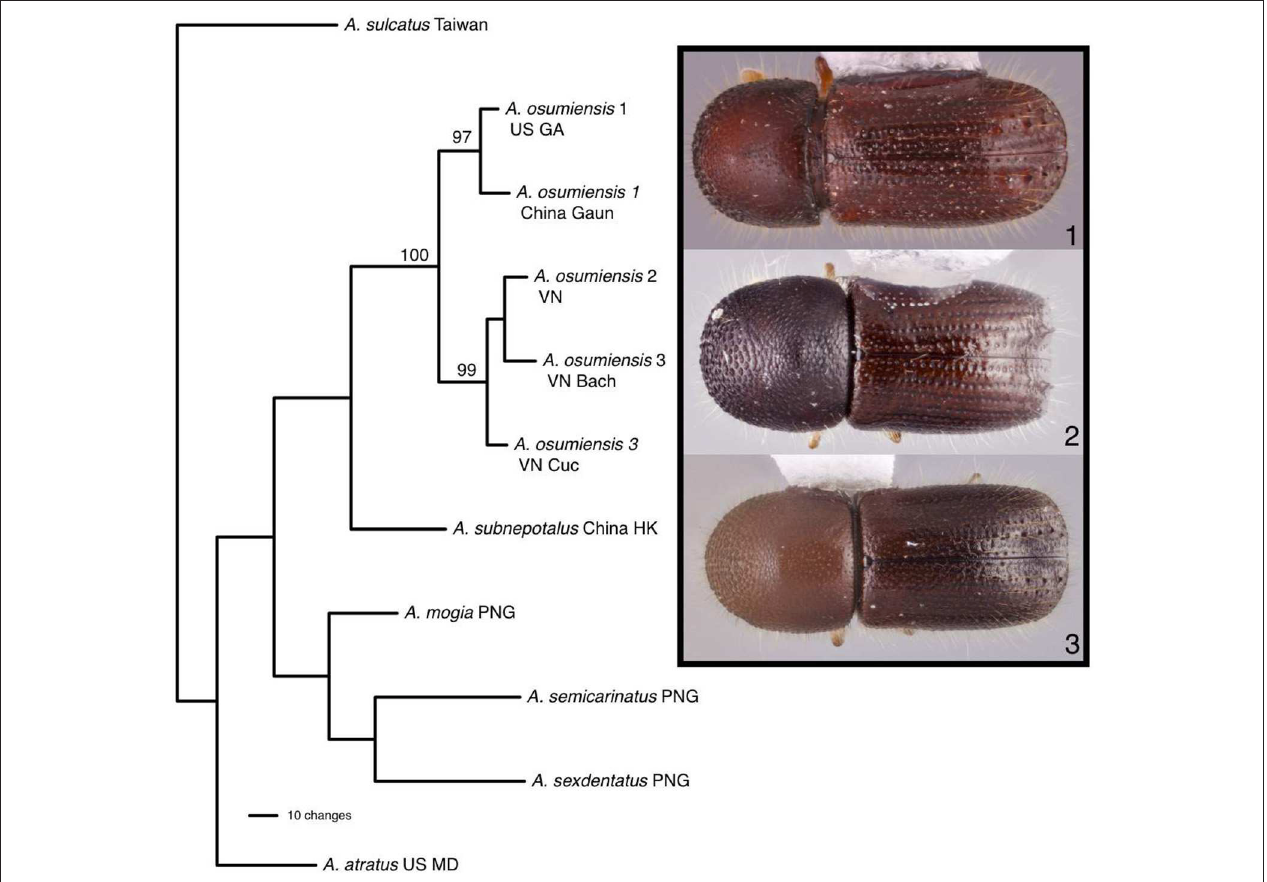
FIGURE 4 | The one most parsimonious tree found for Ambrosiophilus species based on COI and CAD data. Numbers indicate bootstrap values. Habitus images depict morphological variation observed among tubercles of the elytra.